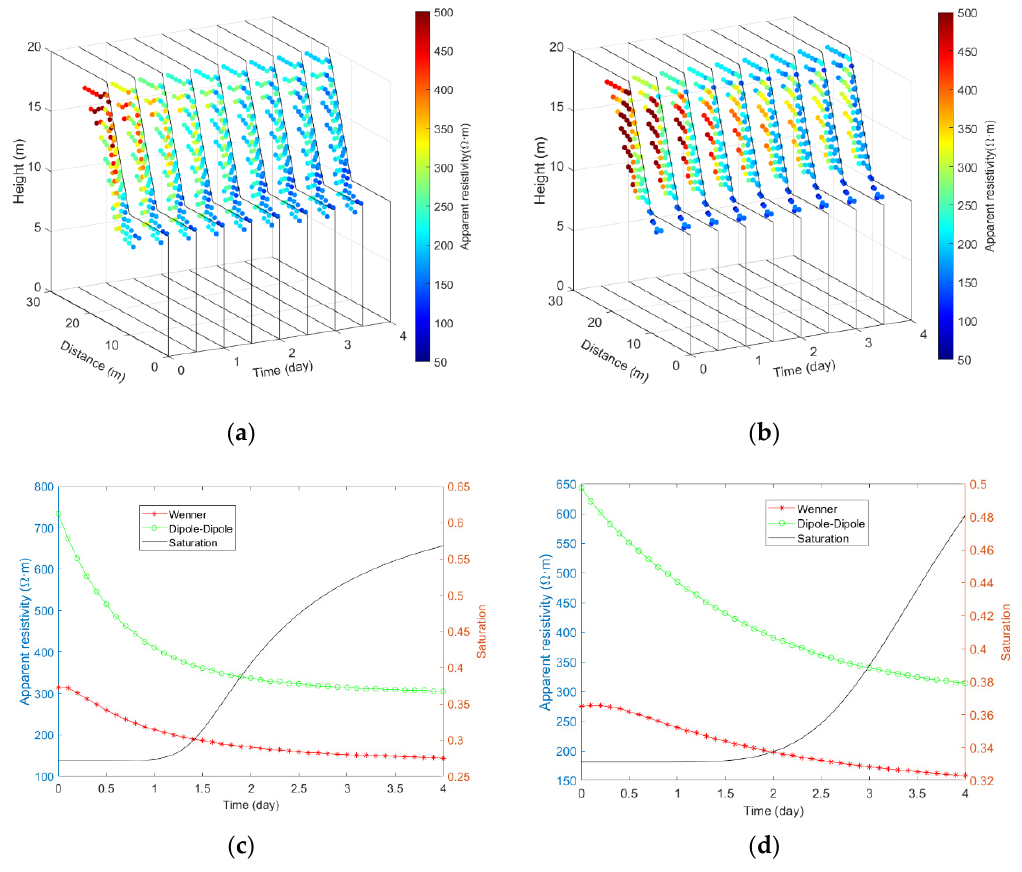
Figure 8. Apparent resistivity response of WECC for Wenner and Dipole-Dipole arrays with 3% uncertainty. ( a ) Wenner array, ( b ) Dipole-Dipole array. ( c ) Apparent resistivity and saturation at point A with time. ( d ) Apparent resistivity and saturation at point B with time.